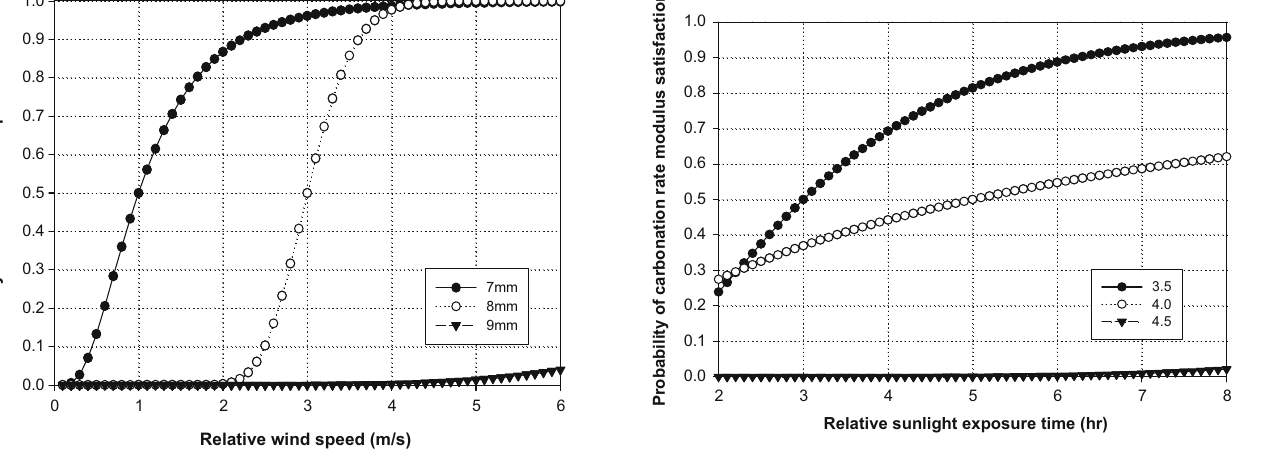
Fig. 9 Satisfaction curve of sunlight exposure time parameter for combine carbonation rate (3.5, 4.0, 4.5).